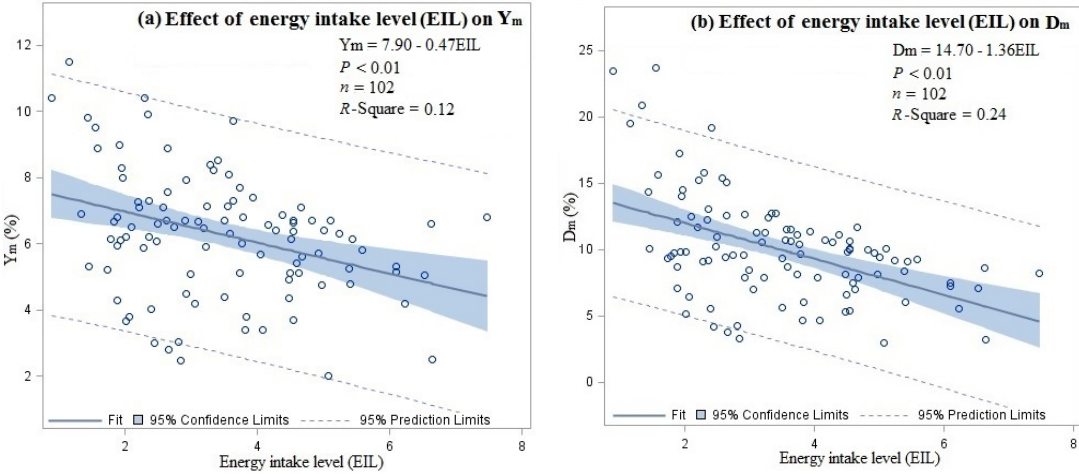
Figure 7. Fit plots for ( a ) Y m (CH 4 loss as a percentage of GEI) and ( b ) D m (CH 4 loss as a percentage of digestible energy intake) as a function of energy intake level (EIL).